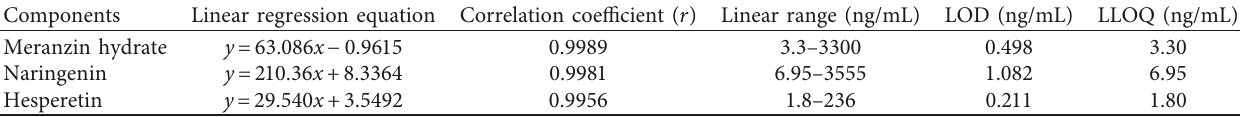
Table 2: Regression equations, correlation coefficients, linear ranges, LOD, and LLOQ of meranzin hydrate, naringenin, and hesperetin in rat